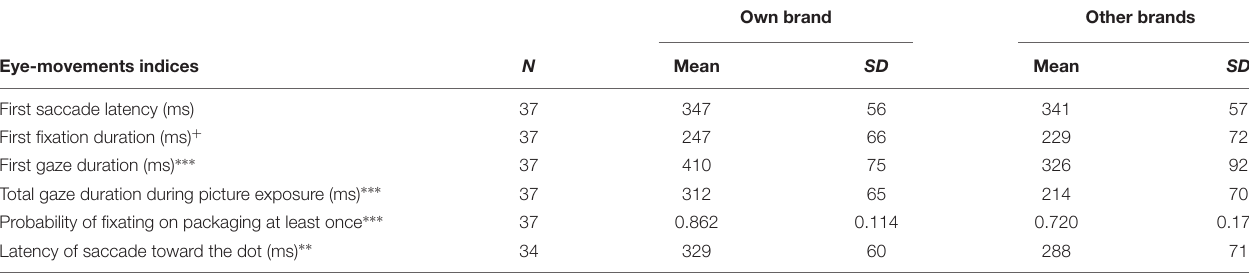
TABLE 1 | Mean scores and standard deviations of indices quantifying eye-movements.